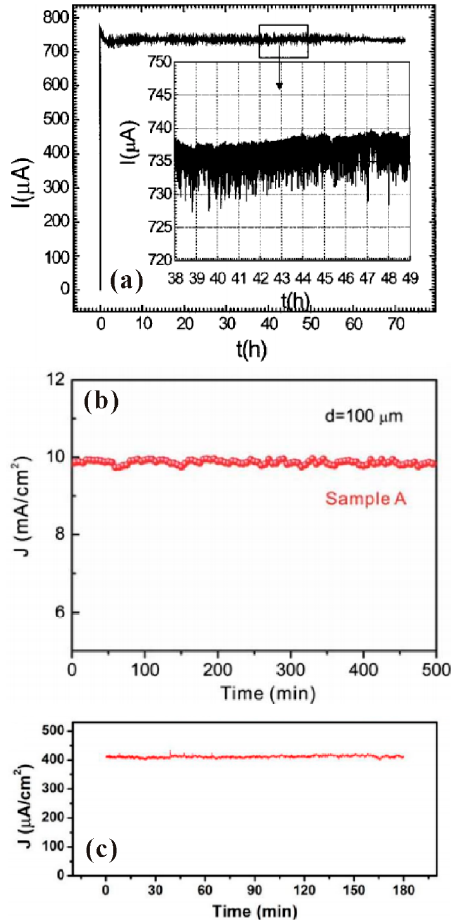
Figure 7. Field emission stability of ZnO nanowires. ( a ) ZnO nanowires painted on Au-Si substrate. Reproduced from [59], with the permission of AIP Publishing, 2004. ( b ) ZnO nanowires grown on Al: ZnO substrate. Reproduced from [46], with the permission of AIP Publishing, 2009. ( c ) ZnO nanowires directly grown from Zn thin film on ITO glass. Reproduced from [38], with the permission of ACS Publications, 2013.